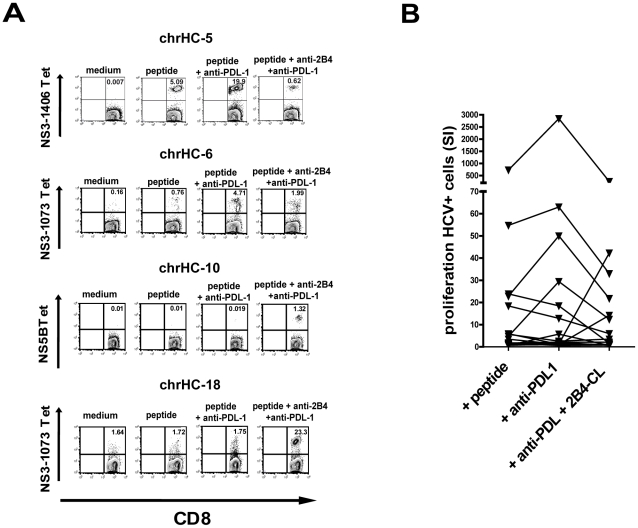
Effect of PD1 blockade and simultaneous cross-linking of 2B4 on the
proliferation of HCV-specific CD8+ T cells in patients with chronic
hepatitis C.PBMC were stimulated in vitro for 10 days with peptide
alone or together with the indicated antibodies or antibody
combinations. (A) Tetramer staining of three representative cell lines
are shown, numbers indicated represent percentages of HCV-tetramer+
cells of CD8+ T cells. (B) Overview of all cell lines analyzed
(n = 20), stimulation indices (SI) of percentages
of HCV-tetramer+ CD8+ T cells referring to medium controls are
given for samples stimulated with peptide alone, additional PD1 blockade
or simultaneous PD1 blockade and 2B4 cross-linking. In most cases
cross-linking 2B4 in combination with PD1 blockade counter-acted the
enhanced proliferation of HCV-specific CD8+ T cells seen upon PD1
blockade alone (6 out of 20). In some cases (3 out of 20) the double
combination resulted in enhanced proliferation of HCV-specific CD8+
T cells, in those cases however, blocking PD1 or stimulating 2B4 alone
was ineffective.